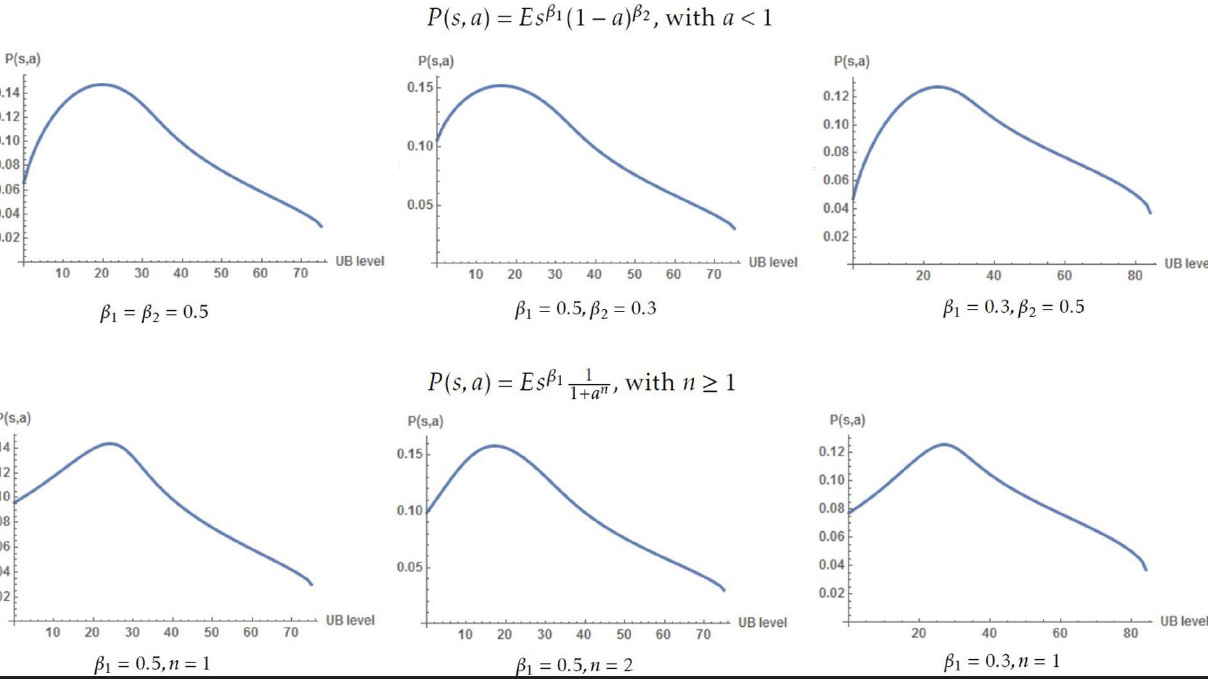
, b and b , n , 1 2 1